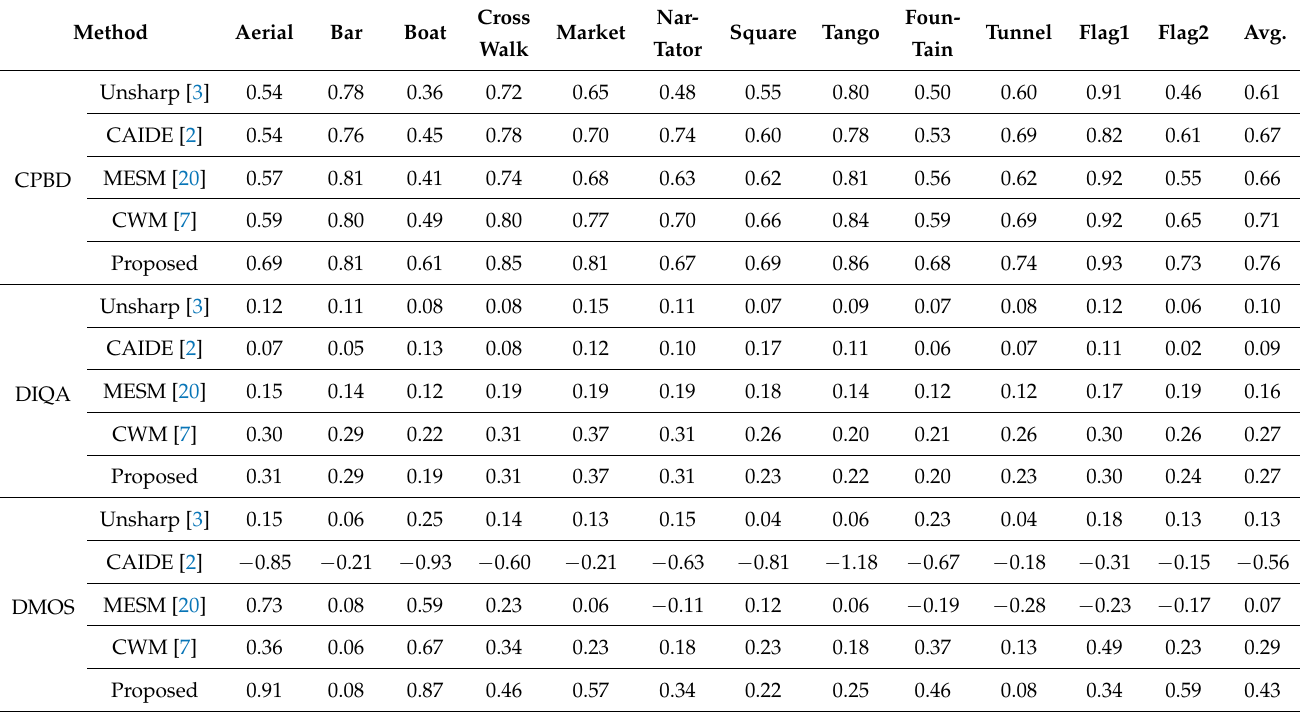
Table 1. Image quality evaluation